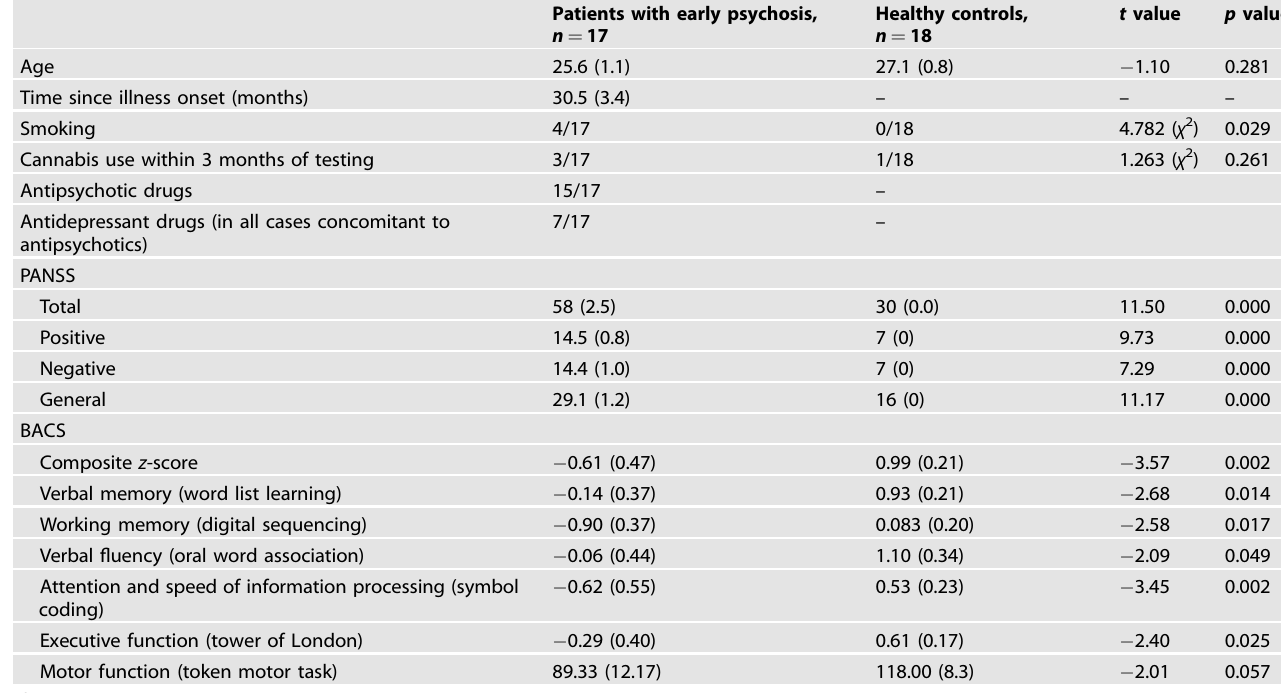
Table 1. Demographic data and clinical scores a